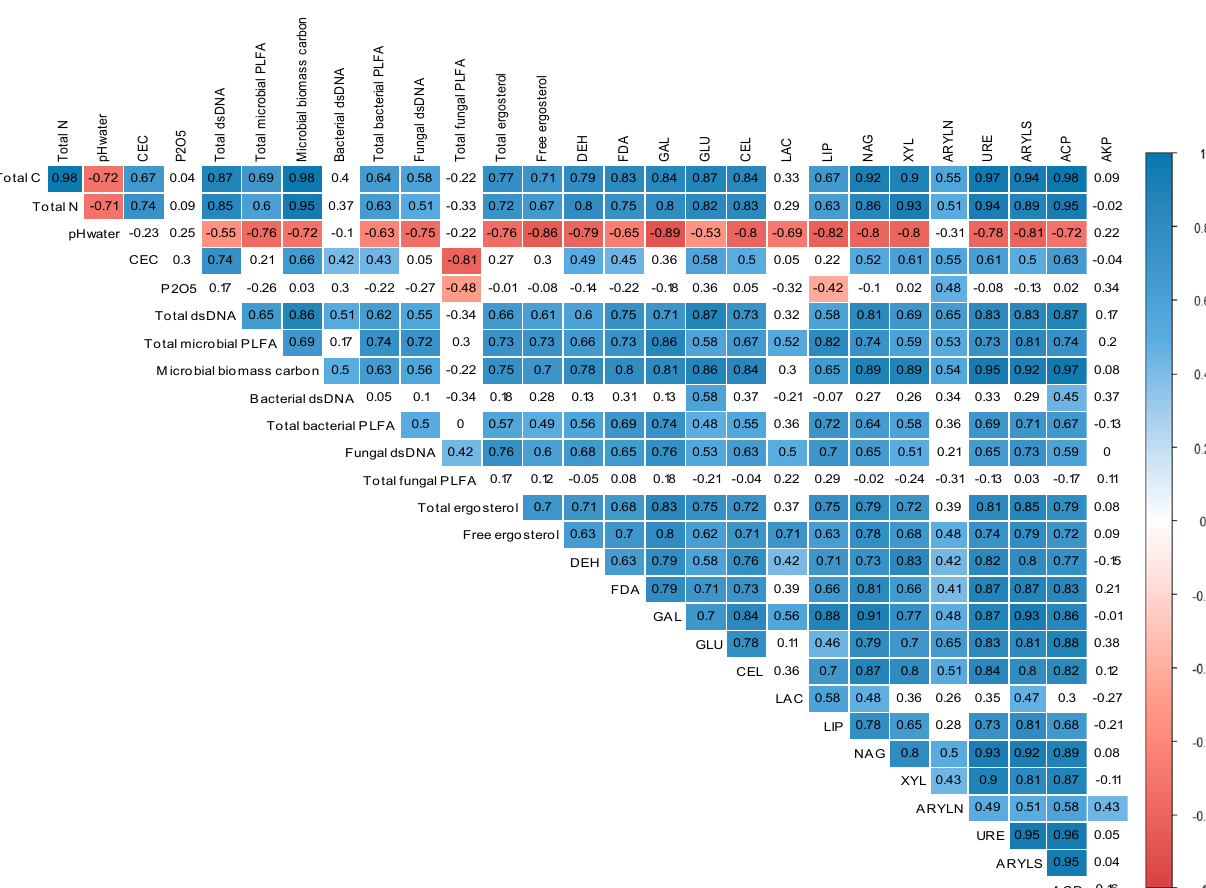
Figure 3. Correlation matrix between physicochemical parameters, microbial abundance, and enzyme activities. Red and blue color indicate statistically significant negative and positive correlations, respectively.